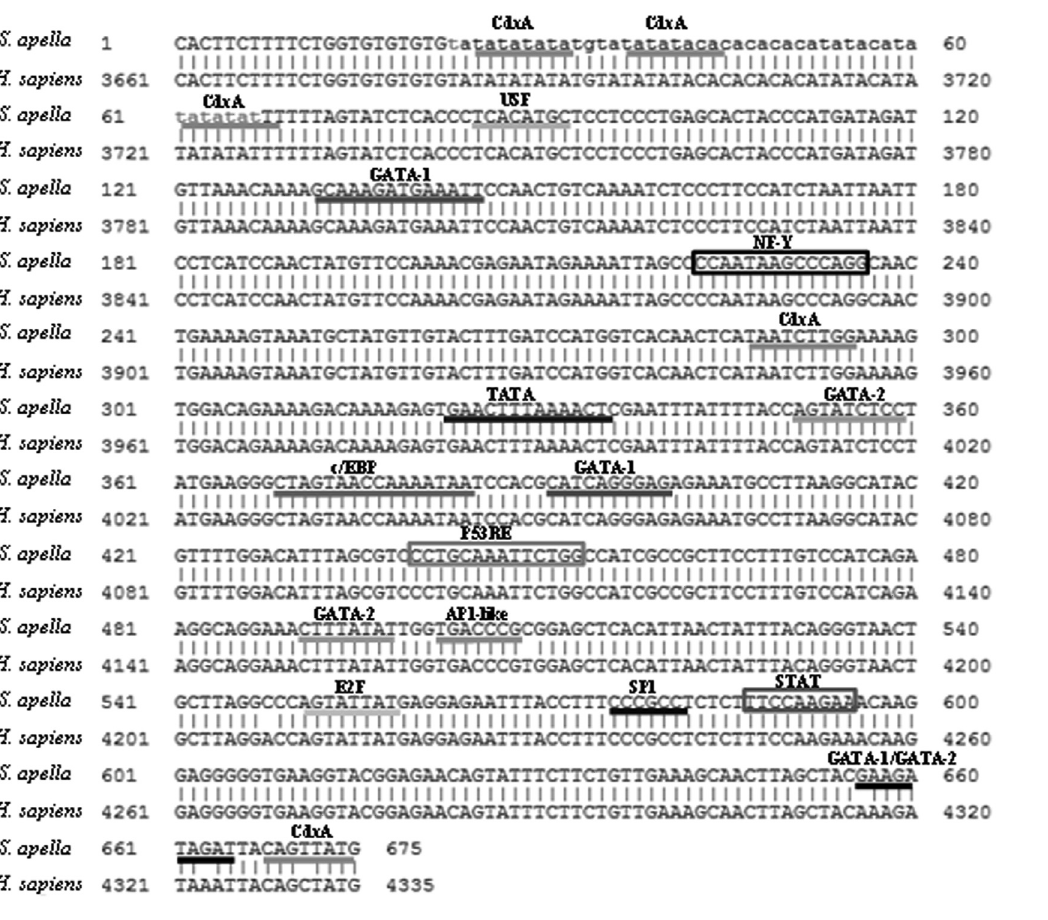
Figure1 -Bindingsitesinthe S.apella sequence.Bindingsitesforregulatorycis-elements(highlightedinboxes)andtranscriptionfactors(underlined)in the S. apella partial promoter